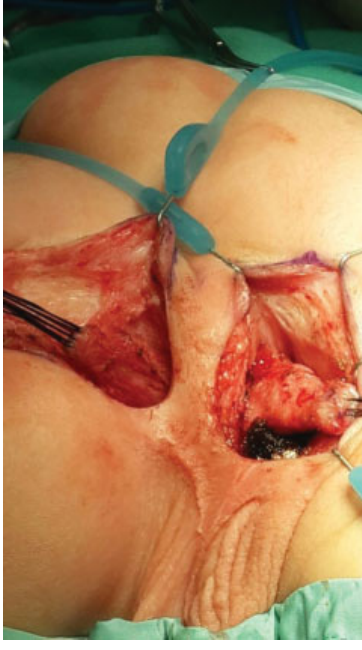
Fig. 7 Mobilization of perineal fi